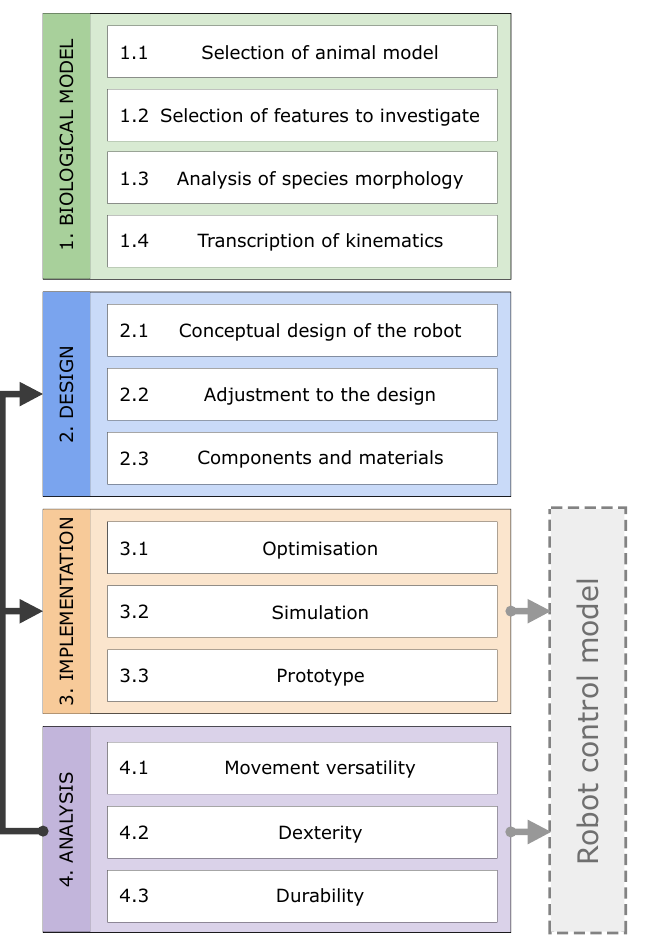
Figure 3. Framework for Developing Bio-Inspired Morphologies for legged robots with four phases: 1. Biological model, 2. Design, 3. Implementation, and 4.